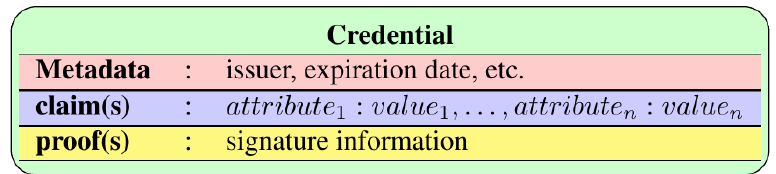
Figure 1. Credential format in Hyperledger Indy.